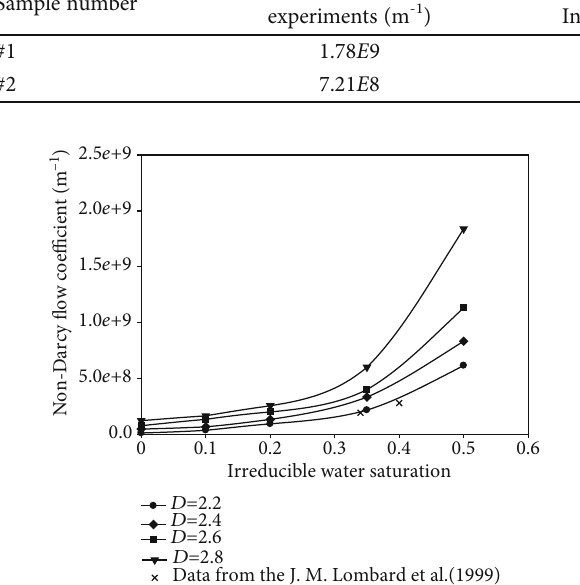
Figure 5: Curves of non-Darcy coe ffi cient and irreducible water saturation at di ff erent fractal